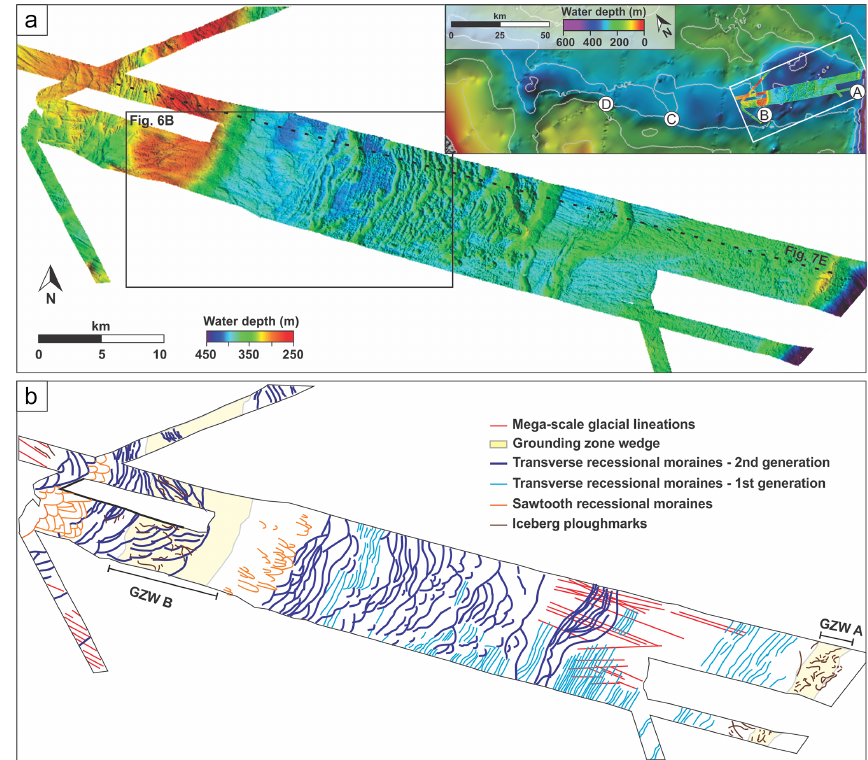
Figure 5. (a) Swath bathymetry map from the outer part of Store Koldewey Trough. The locations of grounding zone wedges A–D are indicated in the inset map (bathymetry from IBCAO v.4.0; Jakobsson et al., 2020). (b) Interpretation and distribution of landforms modified after Laberg et al. (2017), supplemented with new